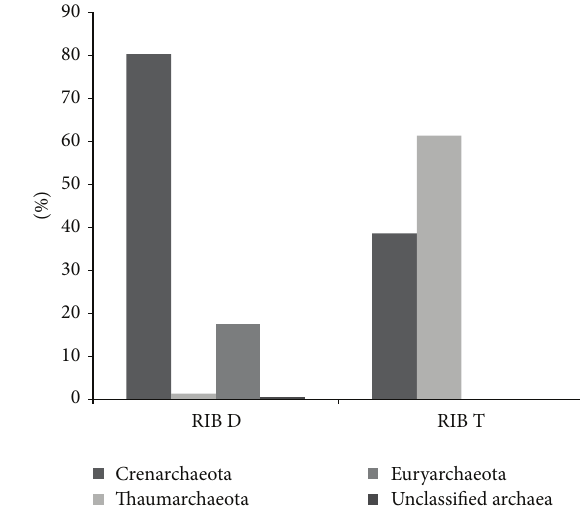
Figure 3: Histogram showing the taxonomic distribution of Cer- rado fresh water lake sediment archaeal sequences obtained in the dry season (RIB D) and the transition between dry and rainy season (RIB T) among different phyla according to the Greengenes